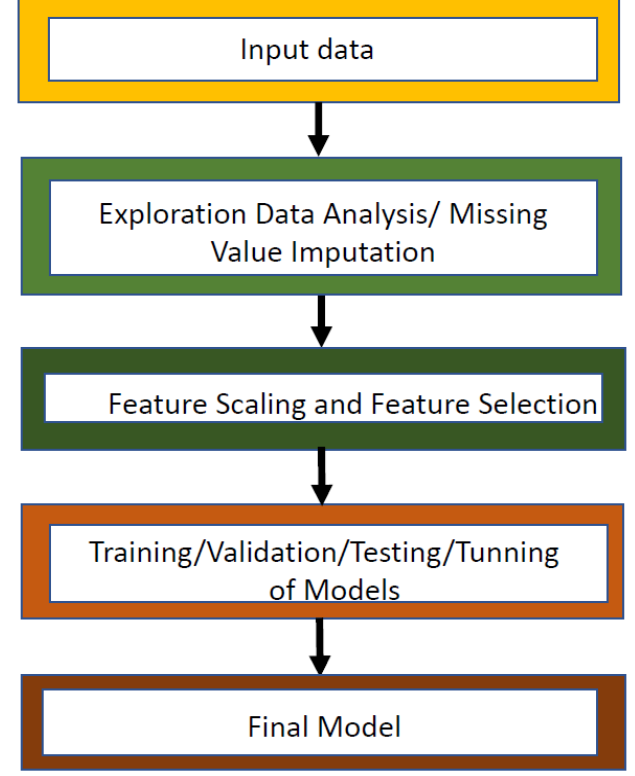
Figure 3. The Flow Chart of the Experimental Process.